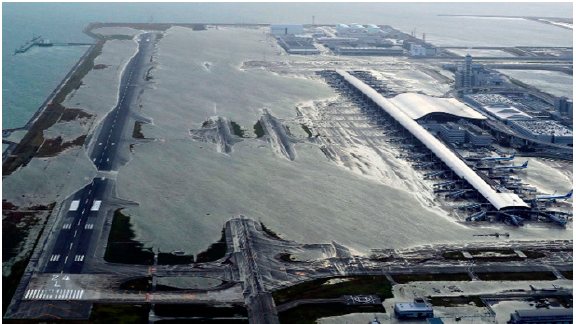
Figure 1. Flooding of Kansai International Airport in Japan caused by typhoon “Jebi” [1].